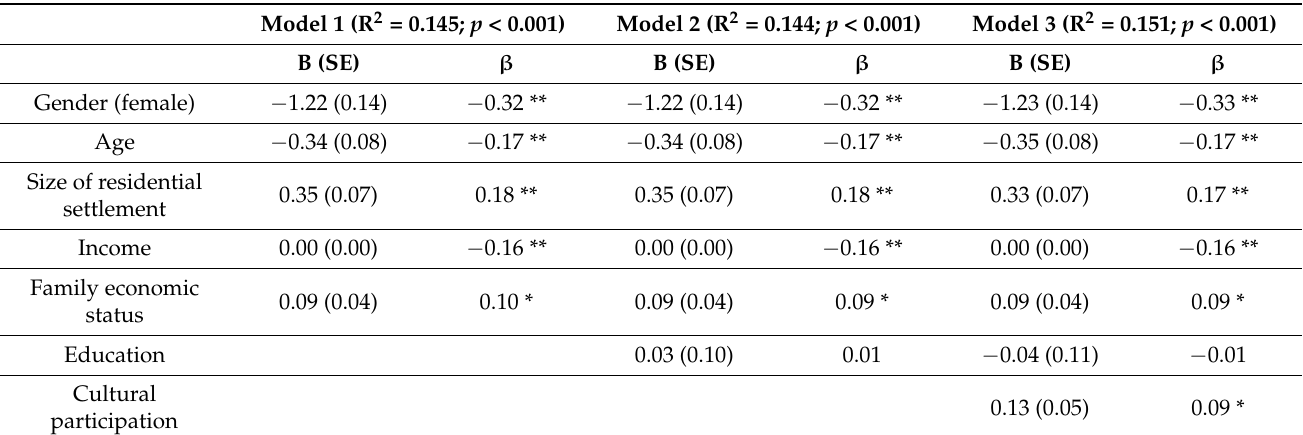
Table 3. Multiple linear regression of pro-vaccine